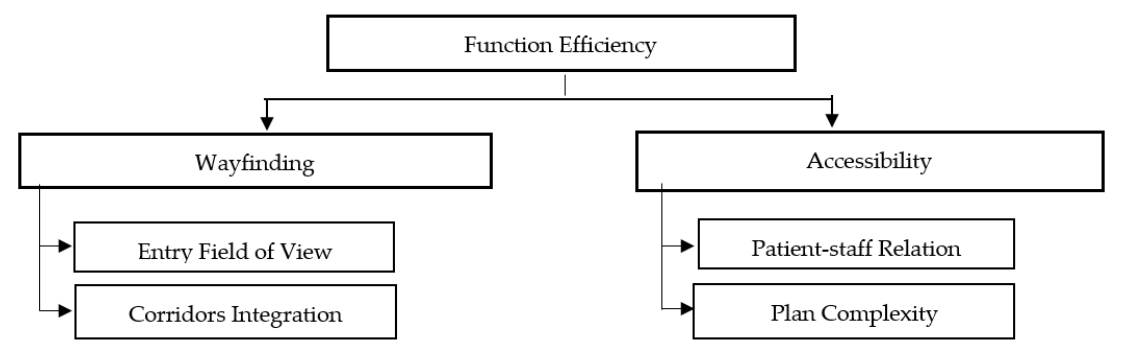
Figure 2. The study factors and